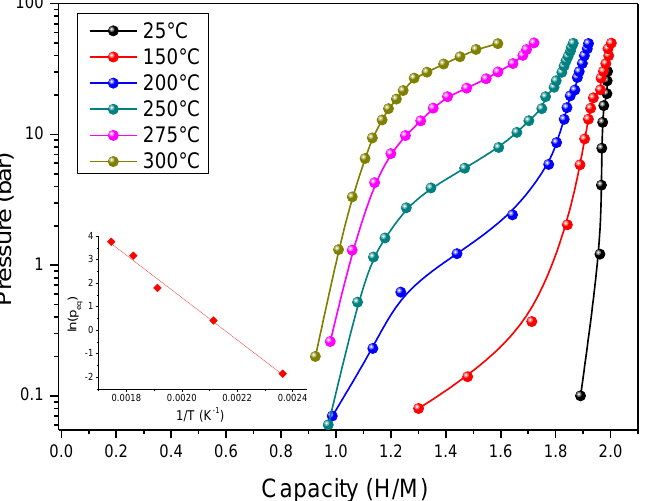
Figure 3. Pressure Composition Isotherms of the Ti 0.30 V 0.25 Cr 0.10 Zr 0.10 Nb 0.25 alloy at various temper- atures from 25 ◦ C to 300 ◦ C. The inset shows the Van’t Hoff plot (ln(p eq ) vs. 1/T). Table 2. Comparison of the hydrogen storage properties of similar HEAs.